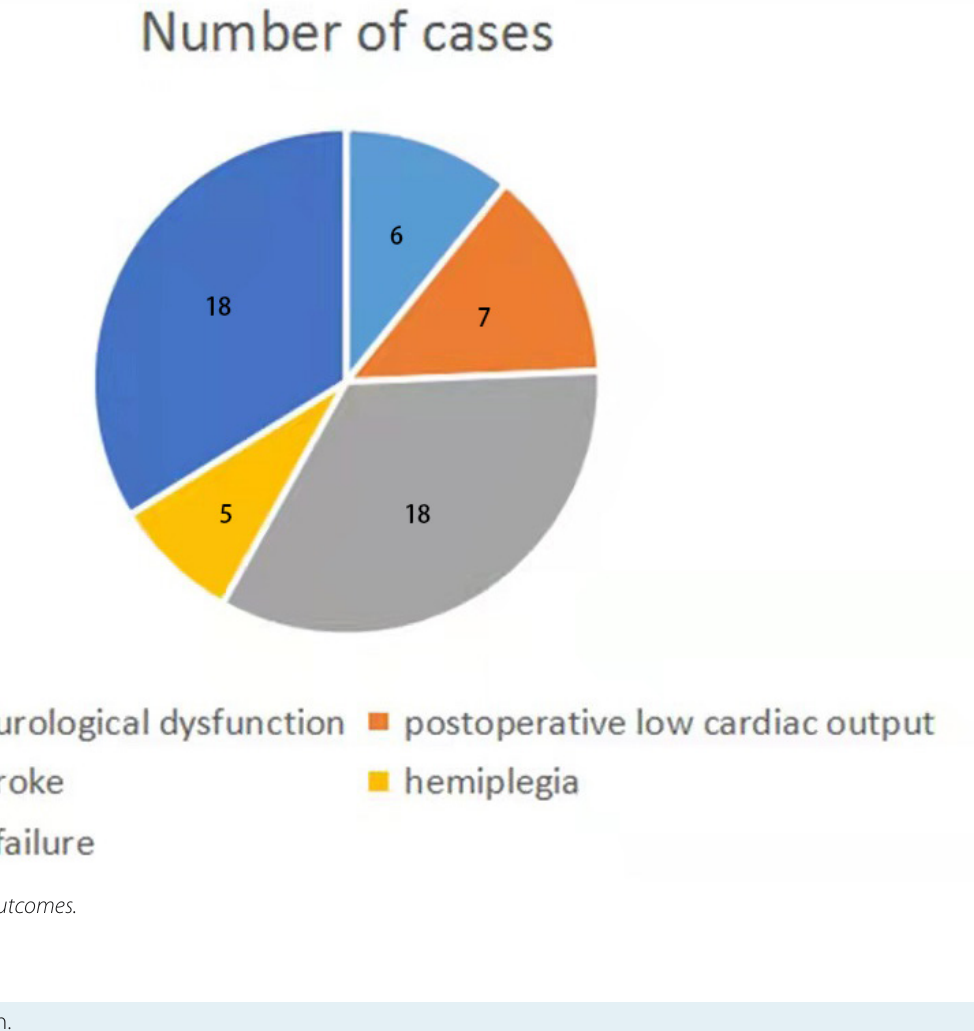
Table 2. Perioperative